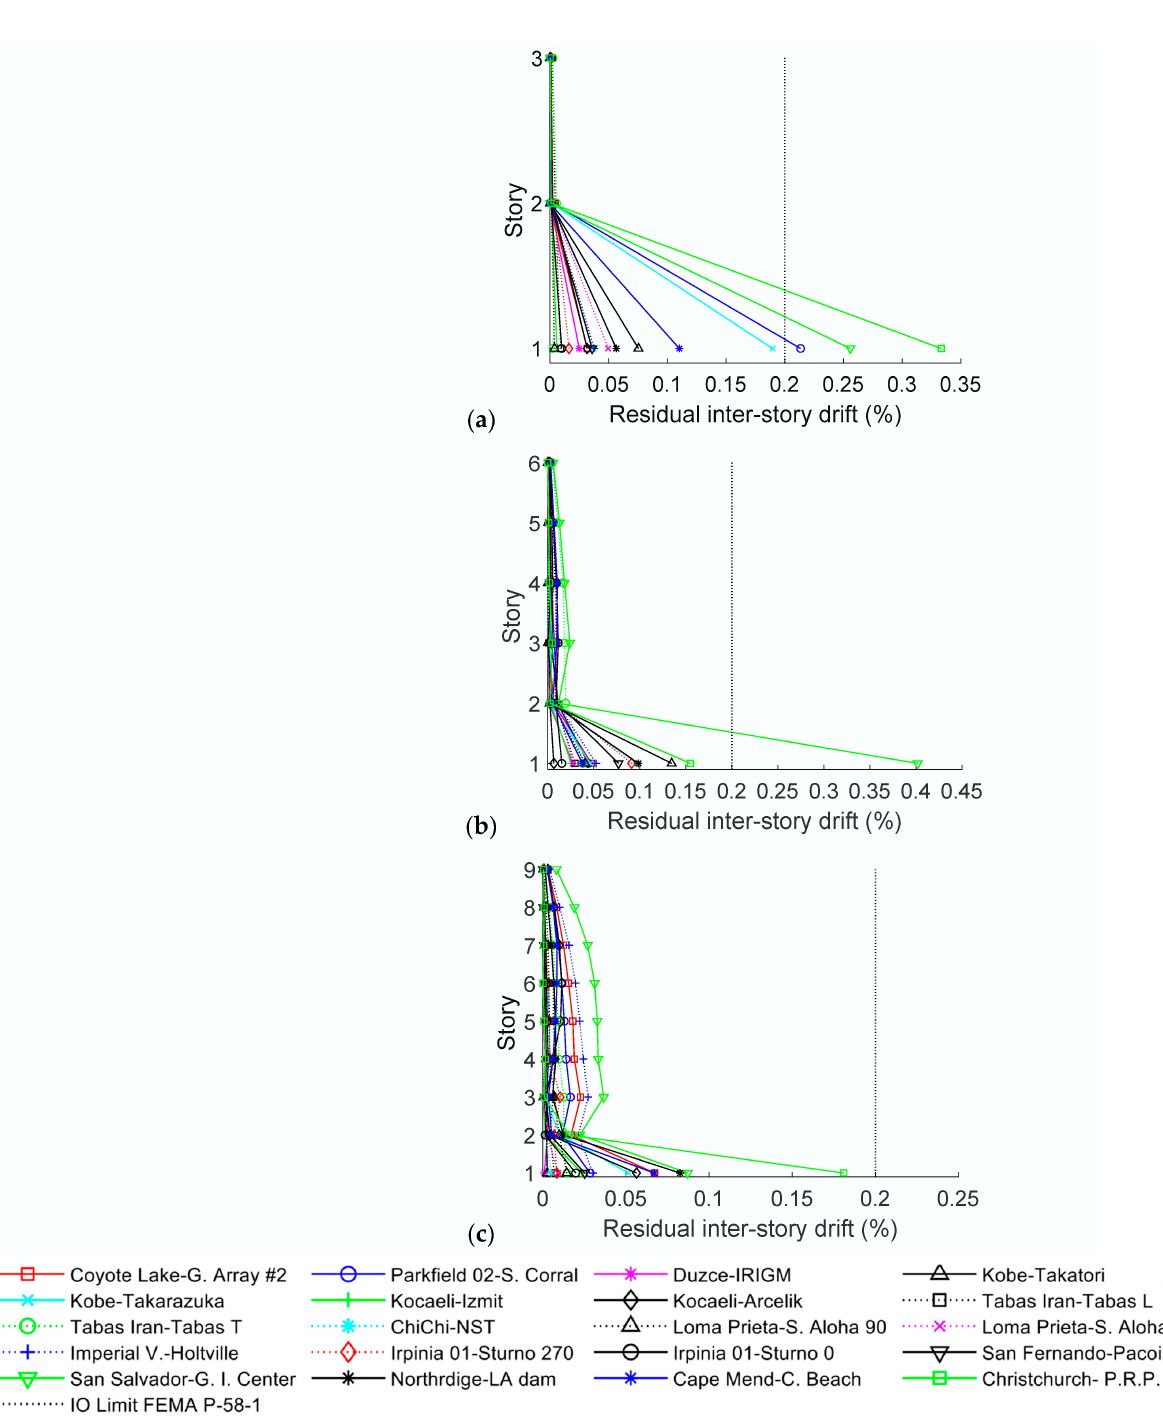
Figure 8. Residual drift ratios for prototypes N3 ( a ), N6 ( b ) and N9 ( c ).